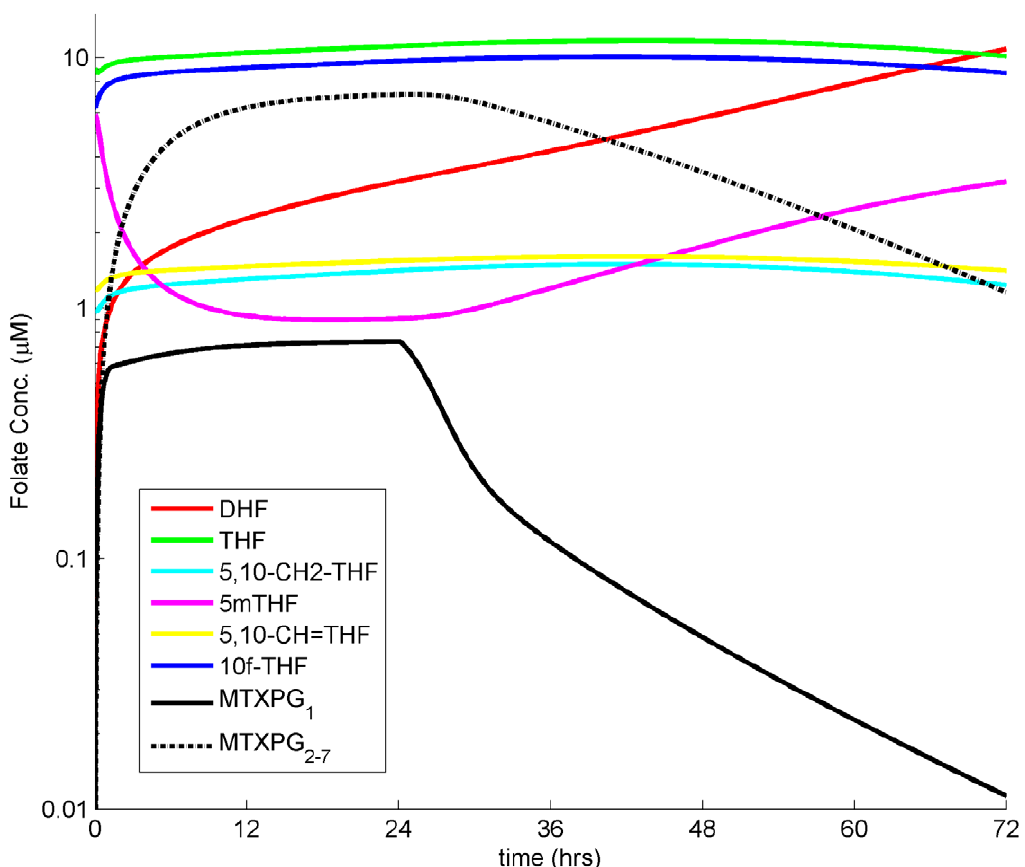
Figure 6. Individual simulated intracellular MTXPG and intracellular folate concentrations vs time. Dose: 1 g/m 2 ; Infusion time: 24 hrs. Red: DHF; Green: THF; Light Blue: 5,10-CH2-THF; Magenta: 5mTHF; Yellow: 5,10-CH=THF; Dark Blue: 10f-THF; Solid Black: MTXPG 1 ; Dashed Black: MTXPG 2-7 . folates. Figure S2 shows plots of the effects of changes in V MAX DHFR and V MAX ACAIRT on their respective activities. For